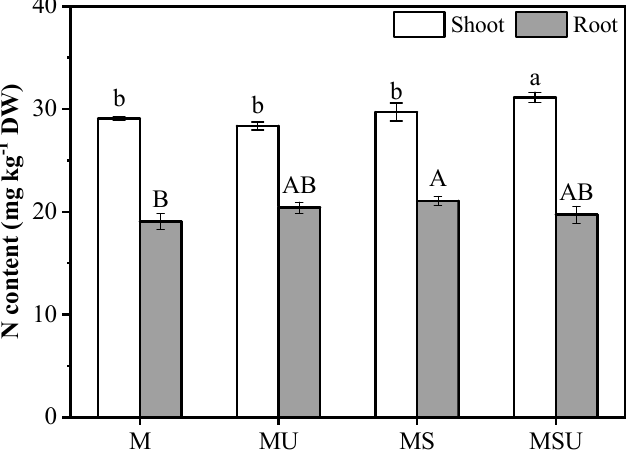
Figure 1. The effect of rhizobium on the total N contents in shoot and root. M: M. sativa , MU: M. sativa + urea, MS: M. sativa + S. meliloti , MSU: M. sativa + S. meliloti + urea. Bars are standard error ( n = 3). Different letters stand for significant difference ( p < 0.05) with Duncan’s post-test.